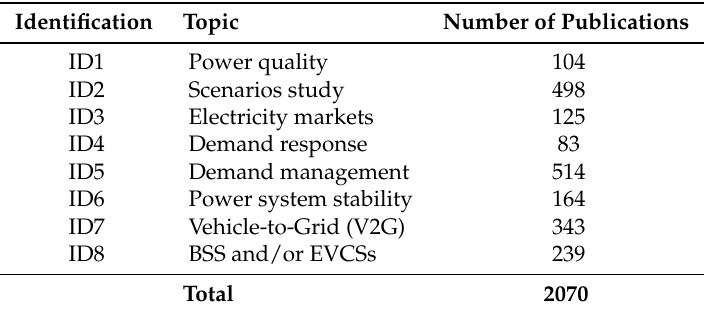
Table 1. Ranking by number of